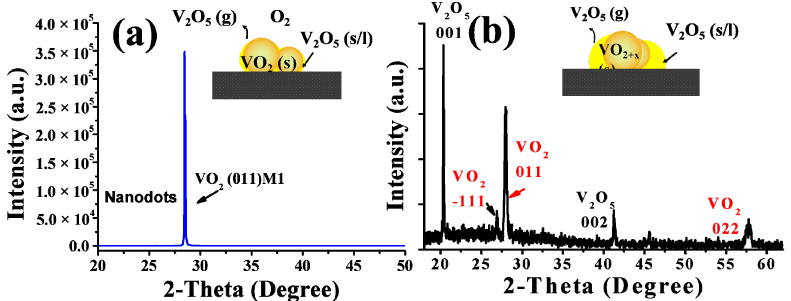
Figure 7. XRD results for VO 2 films that were annealed at 540 °C for 1 h with 0.20 kPa ( a ) and 0.24 kPa ( b ) oxygen injection. The insets in the XRD patterns indicate the growth mode of the corresponding films.